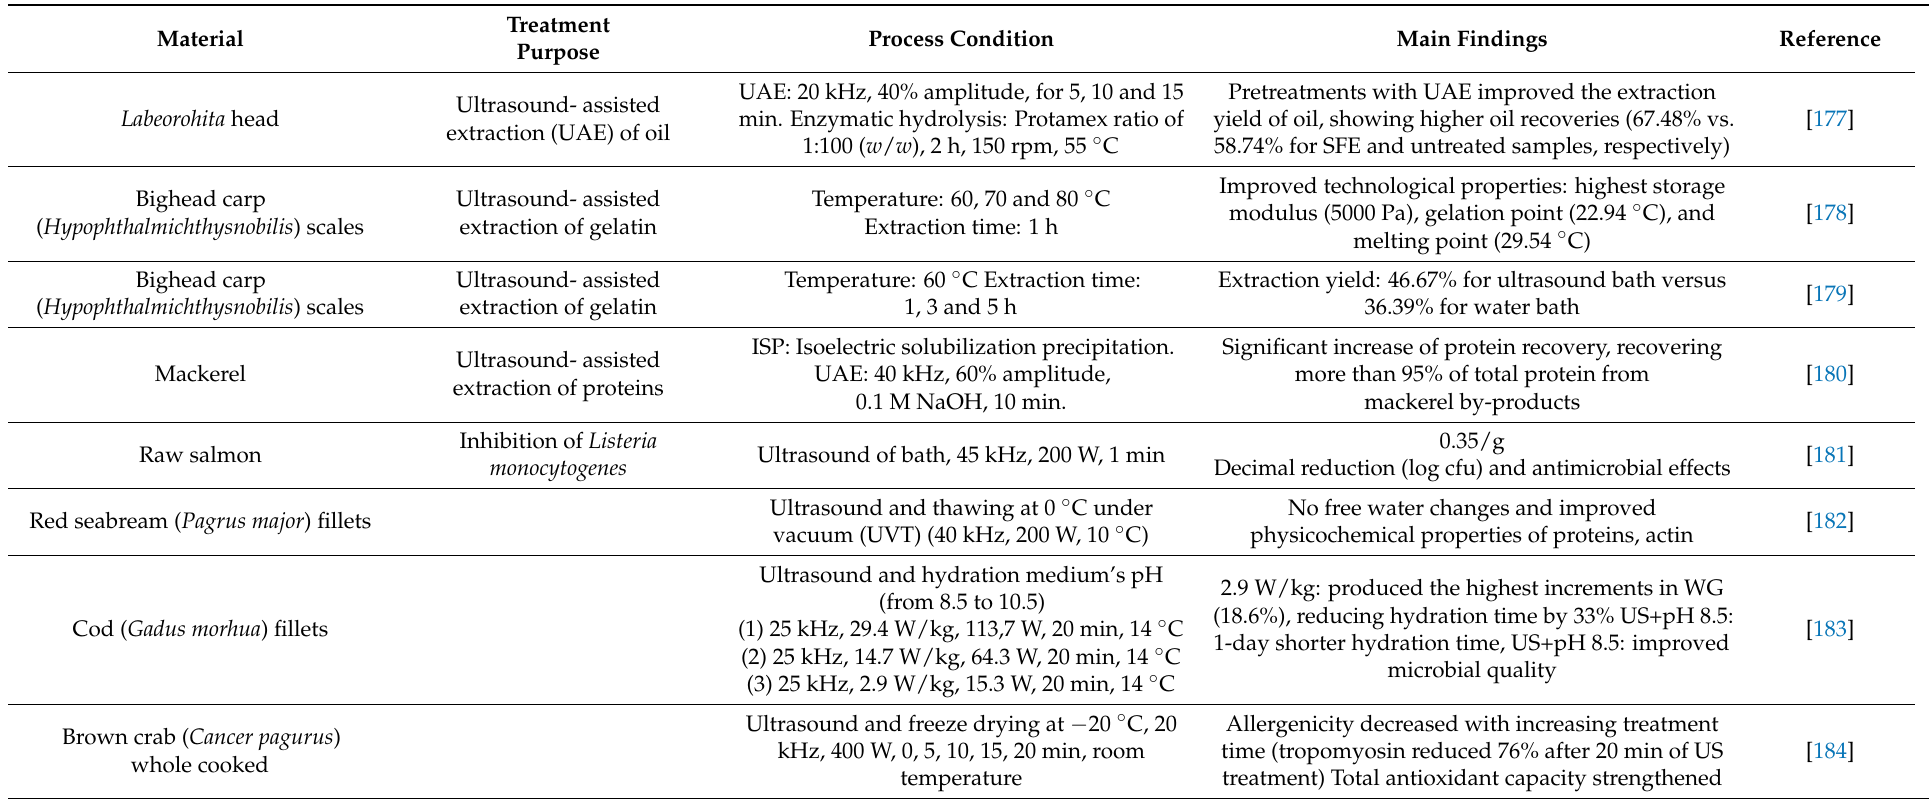
Table A3. Applications of ultrasound technology on various seafood